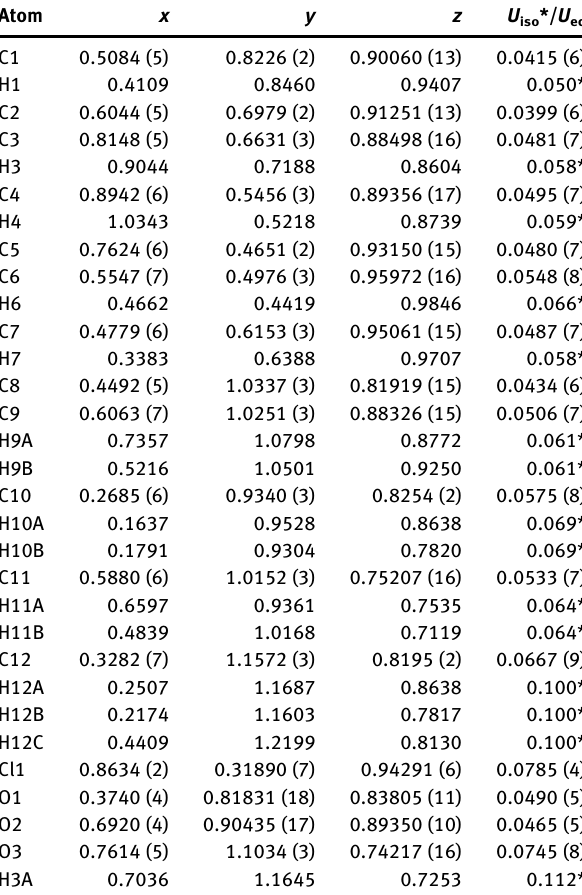
Table  : Fractional atomic coordinates and isotropic or equivalent isotropic displacement parameters (Å 